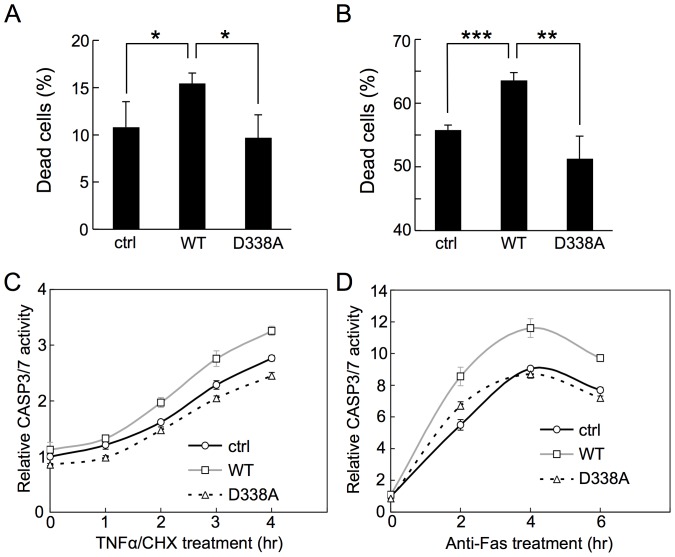
Cleavage of TRB3 promotes apoptosis along with CASP3 activation.(A and B) Twenty-four hours after transfection of HeLa (A) and Jurkat (B) cells with the indicated V5-TRB3 expression plasmid or control (ctrl) vector, the cells were treated with TNFα/CHX for 4 hr (HeLa cells) or anti-Fas antibody for 6 hr (Jurkat cells). The resulting dead cells were counted by trypan blue staining. Error bars indicate mean ±SD of three independent experiments. *P<0.05, **P<0.005, ***P<0.001, statistically significant difference. (C and D) Twenty-four hours after transfection with the indicated V5-TRB3 expression plasmid or control vector, HeLa (C) and Jurkat (D) cells were reseeded in 96-well plates (1.0×104 cells/well), and then treated with TNFα/CHX and anti-Fas antibody, respectively, for the indicated times and CASP3/7 activity was then measured using the luminometric Caspase-Glo® 3/7 Assay Kit. Each data point represents mean ±SD of three independent experiments.